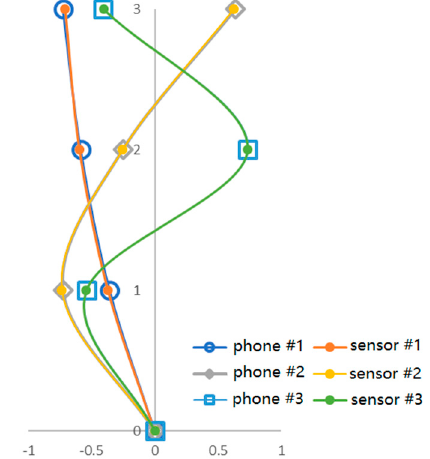
Figure 22. Comparison of estimated mode shapes.